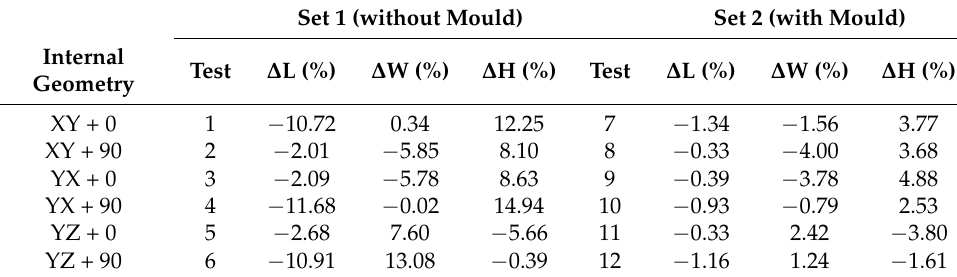
Table 4. Average dimensional changes after thermal treatment. Set 1 (without Mould) Set 2 (with